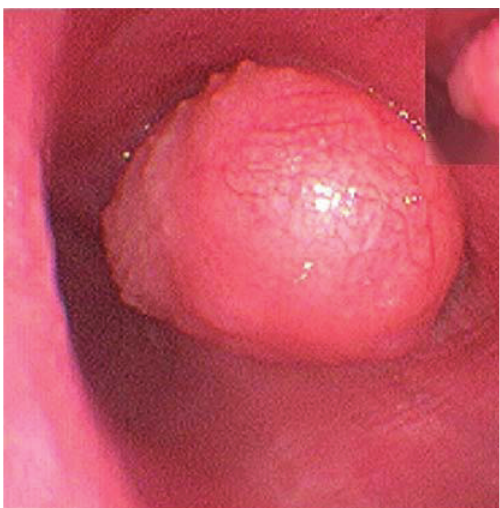
Figure 4: Endoscopy showed soft mass with irregular surface in the right